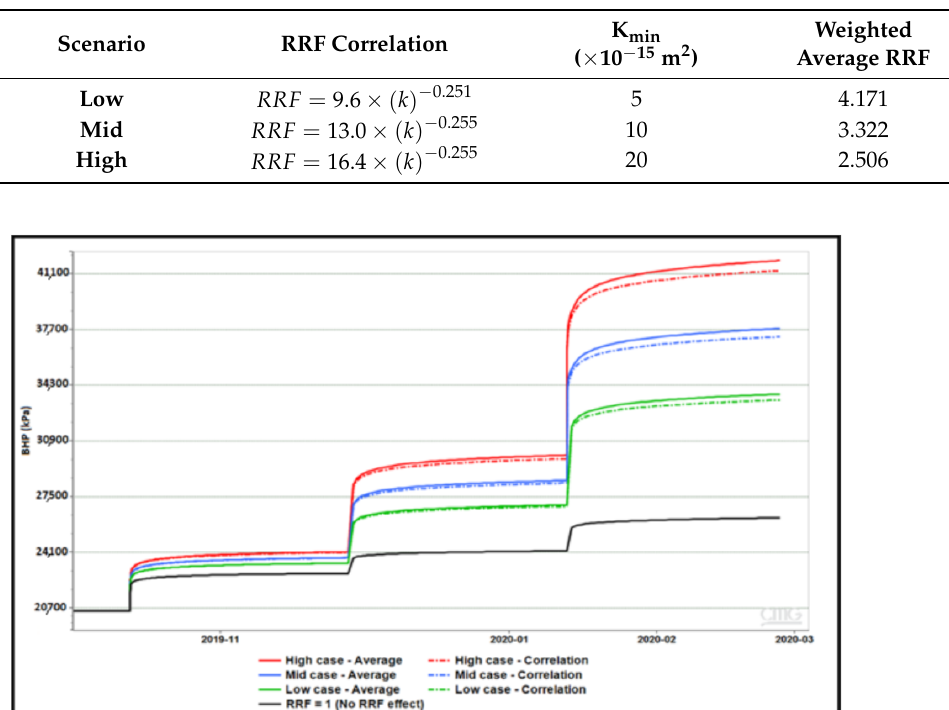
Table 4. Correlations proposed to fit RRF lab data with their respective weighted average.